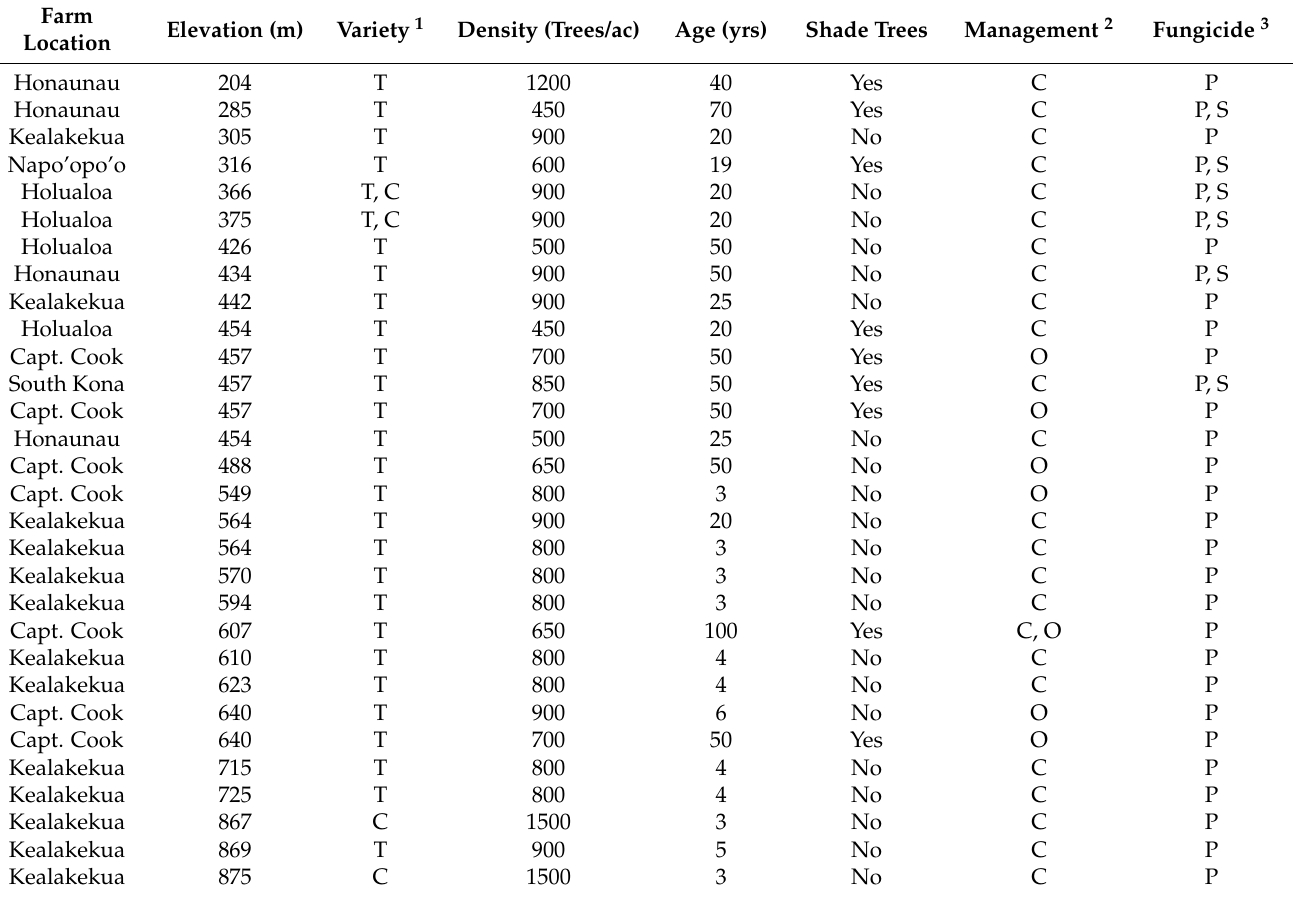
Table 1. Agronomic and management characteristics for 30 coffee lots located in the Kona district of Hawaii